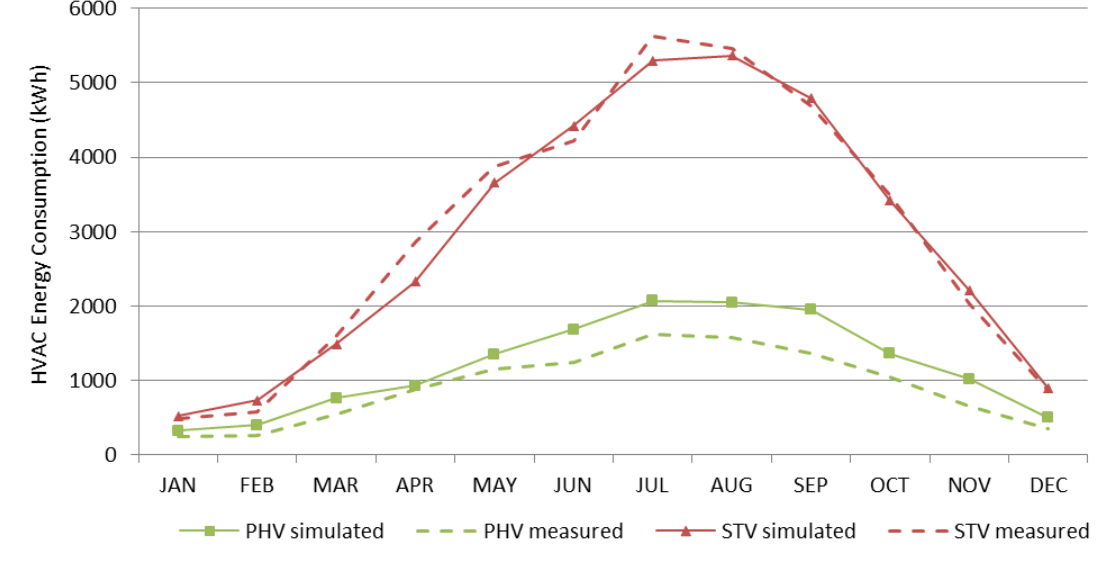
Figure 6. PHV and STV measured and predicted HVAC energy